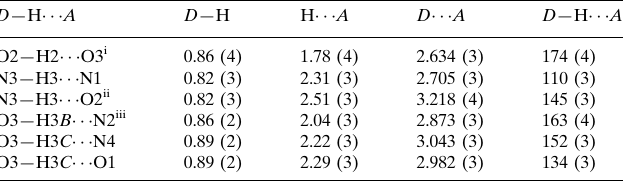
Additional hydrogen bonds between the water molecule and